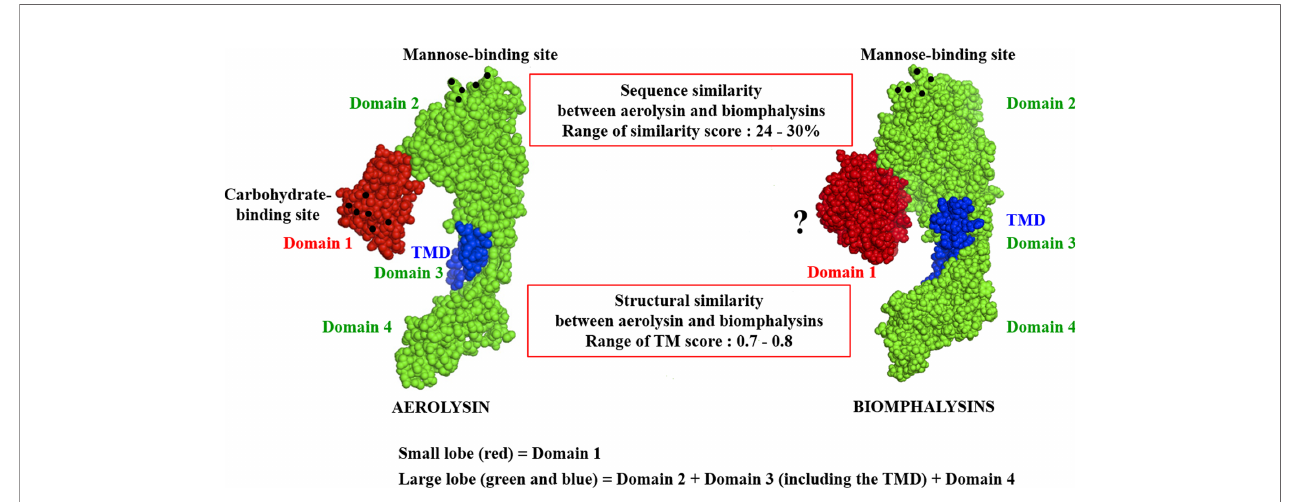
FIGURE 4 | Structural schematic representation of biomphalysins. Images of 3D structure of aerolysin (PDB accession code: 1PRE) and predicted biomphalysin 1 were generated using PyMOL in sphere style. The small domain of both proteins is colored in red, the large domain in green and the TMD in blue. Amino acid residues involved in glycan recognition are symbolized by black spheres. “ ? ” means that no motif has been detected using motif prediction software such as the SMART and MotifScan programs.